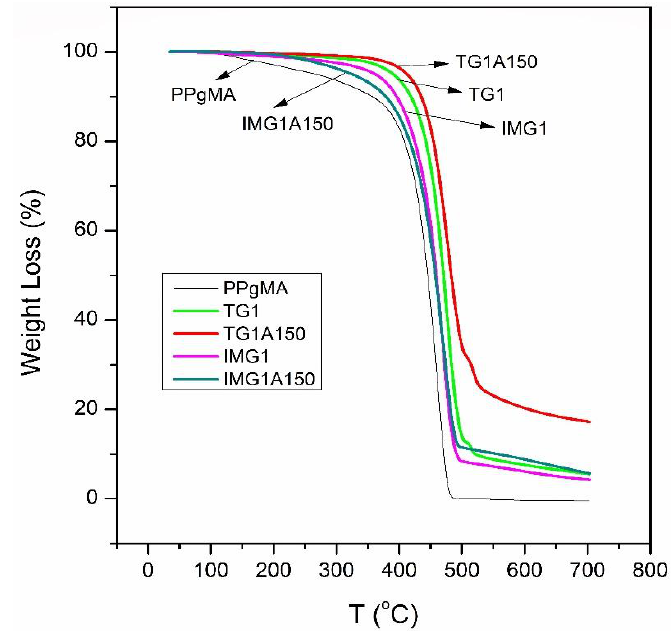
Figure 11. Thermal stability of maleated PP and its cross-linked products.